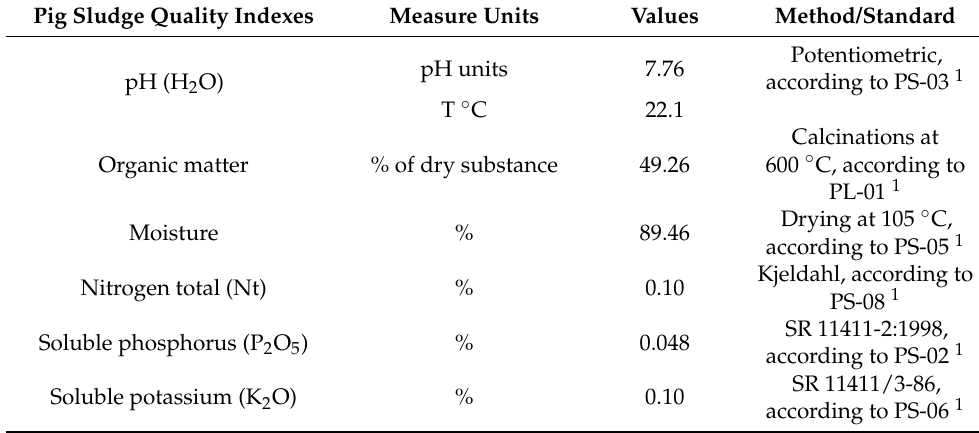
Figure 2. Pig sludge fermentation tank, SC Smithfield Romania SRL, Timis Table 1. Quality indices for pig sludge used to fertilize the studied land, pasture category. Pig Sludge Quality